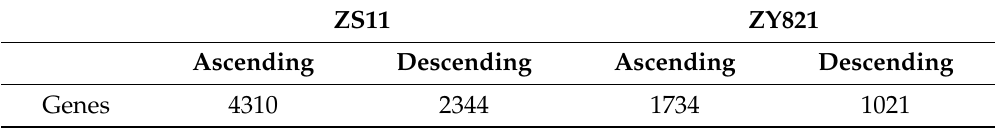
Table 1. Numbers of significant Monotonically Expressed Genes in ascending and descending order for the seeds of two cultivars of B. napus namely ZS11 and ZY821.